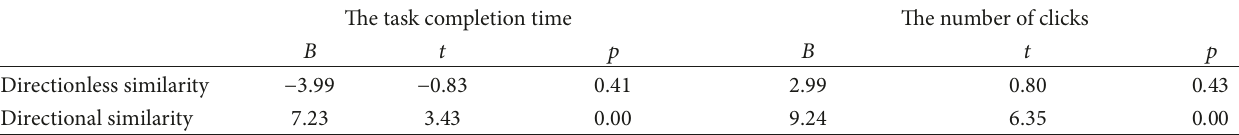
Table 3: Linear regression results of mental model similarity on user